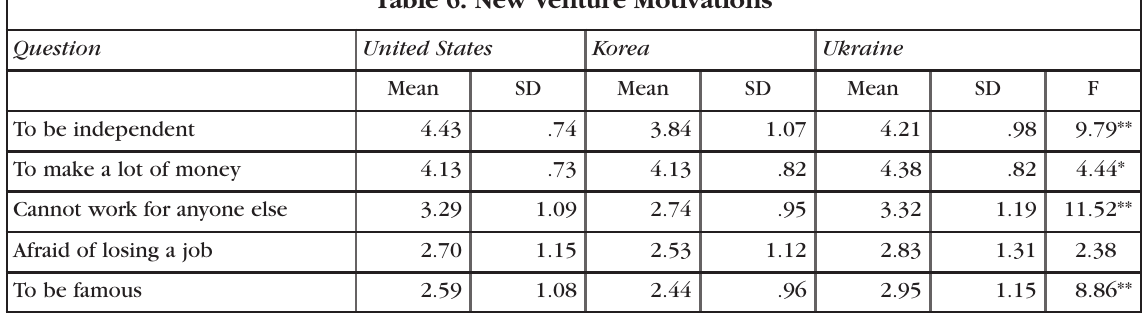
Table 6. New Venture